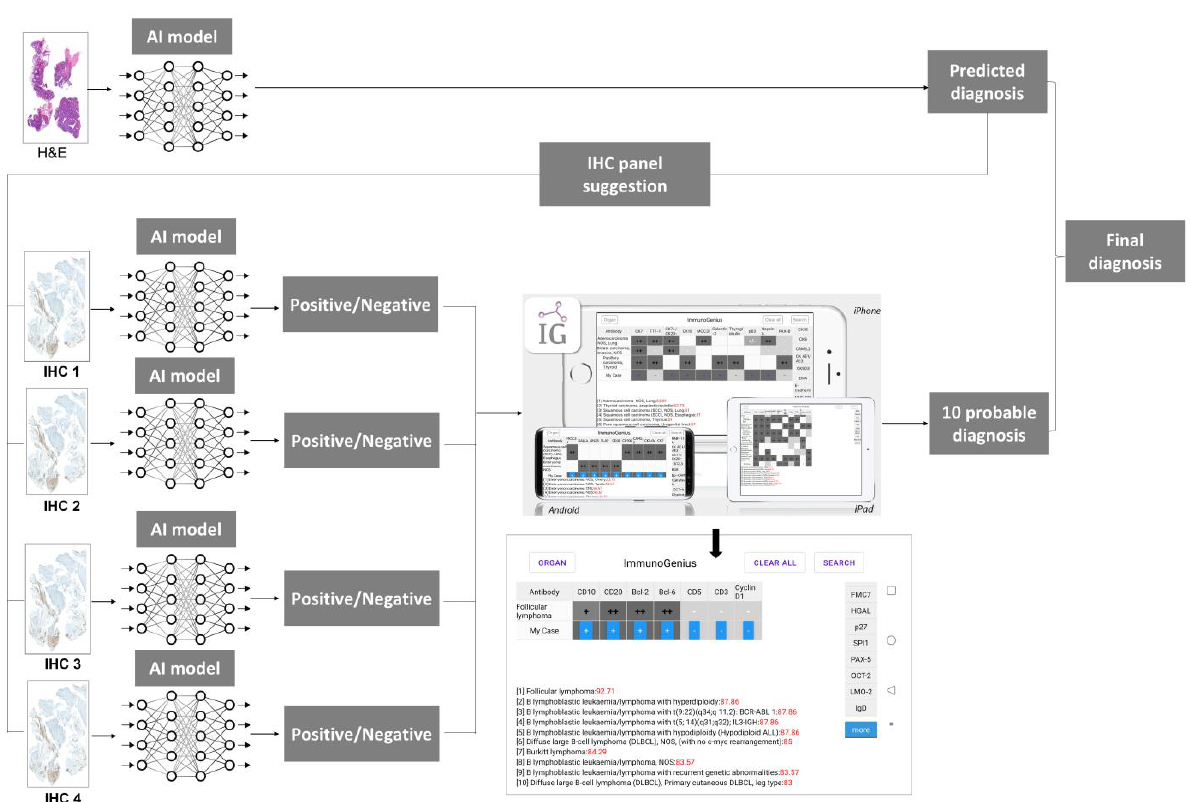
Figure 3. A schematic diagram showing the integrated H&E, IHC AI model with ImmunoGenius.